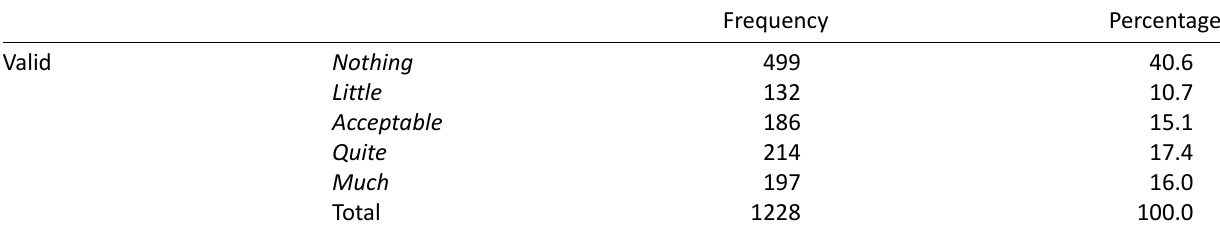
Table 1. Frequency descriptives (producer–X1).